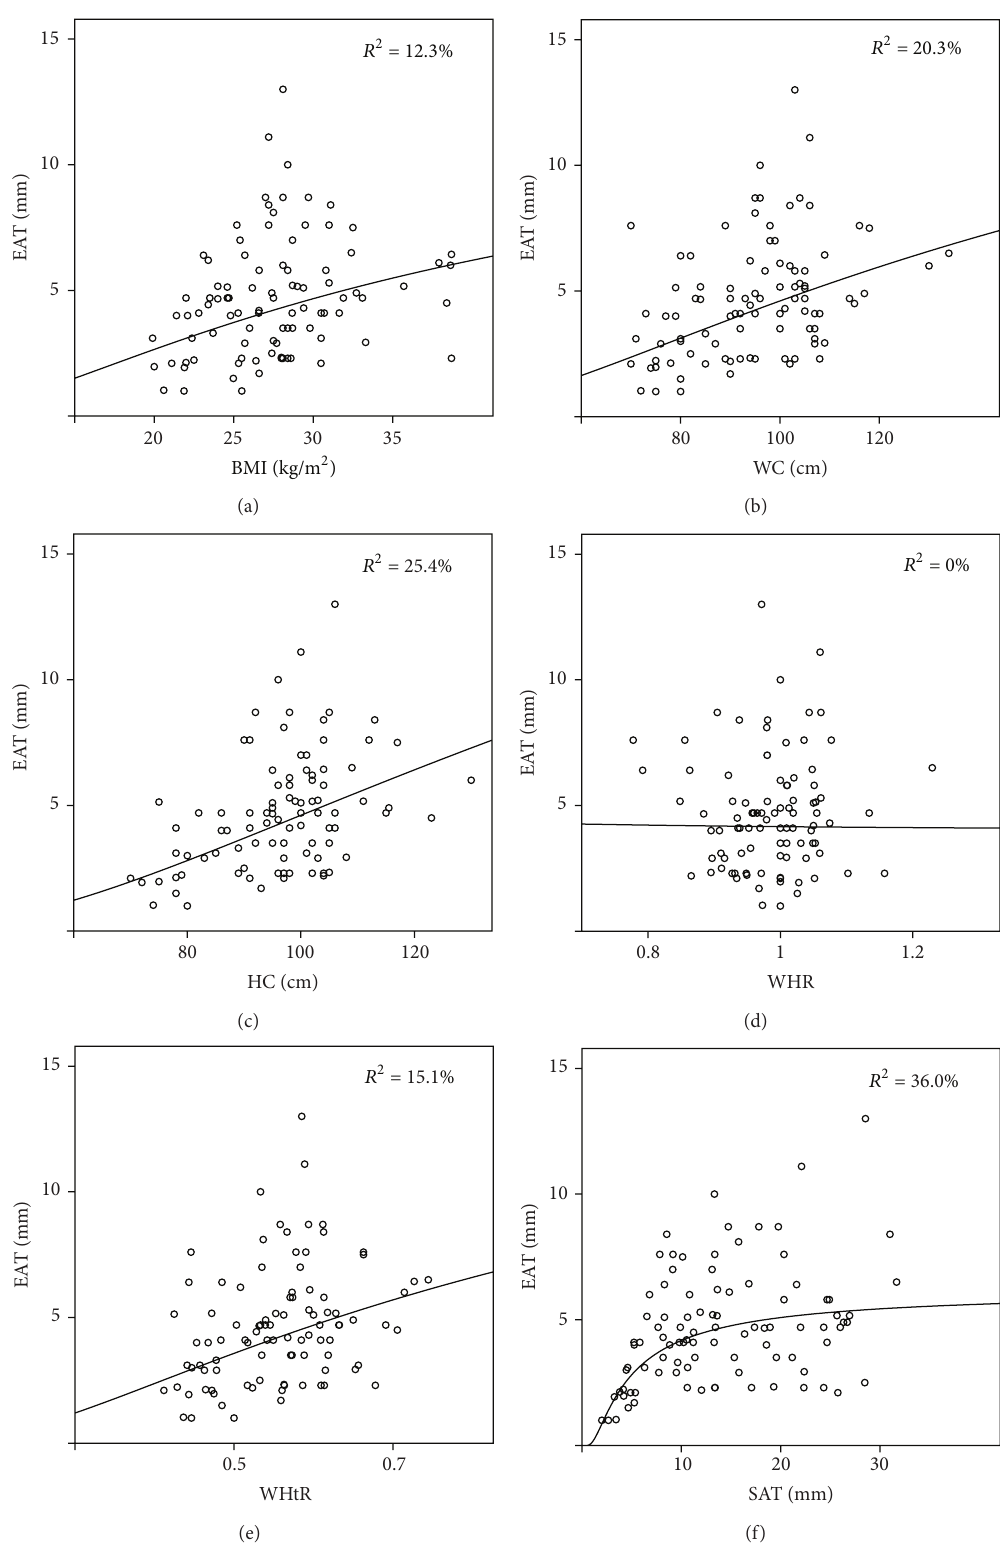
Figure 1: Nonlinear S curve relationship of EAT thickness with anthropometric measures and SAT